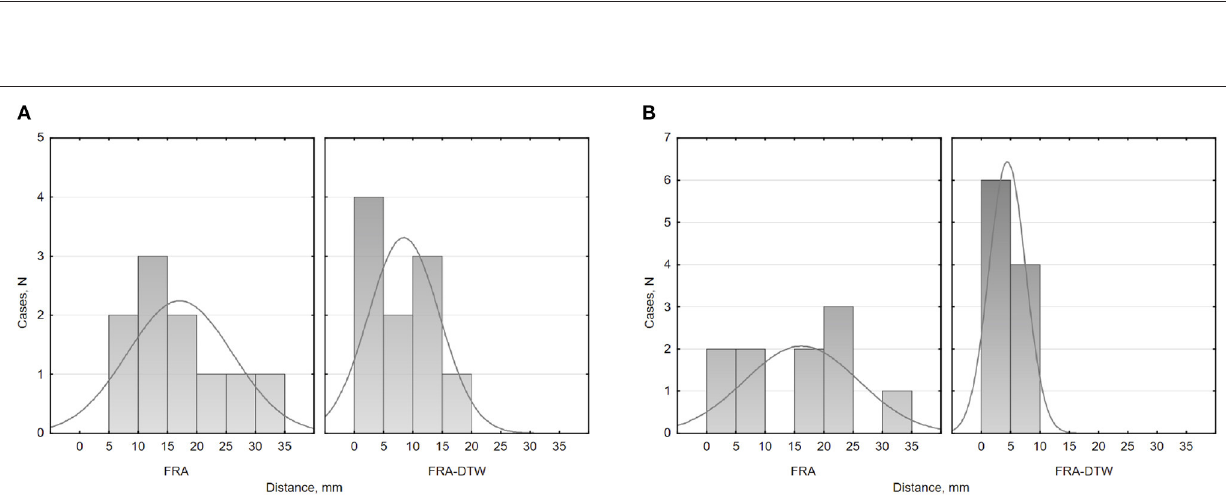
Frontiers in Physiology |